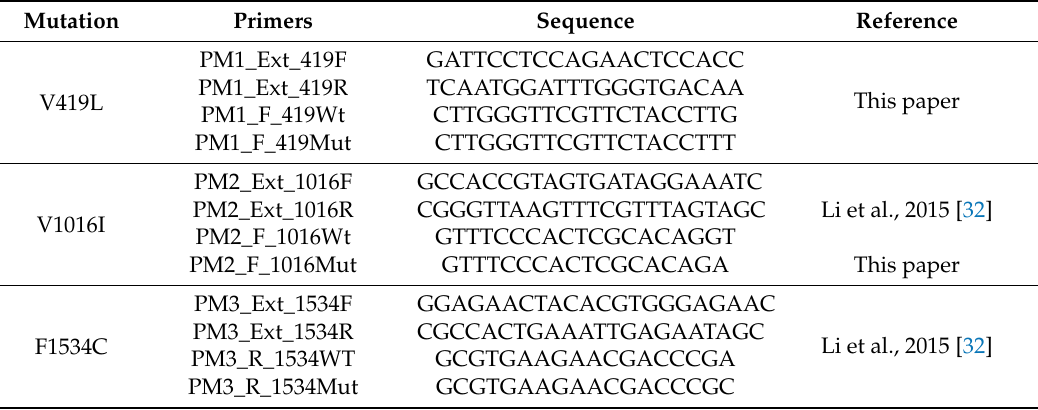
Table 1. Allele-specific primers used in genotyping of Aedes aegypti from Colombia. Mutation